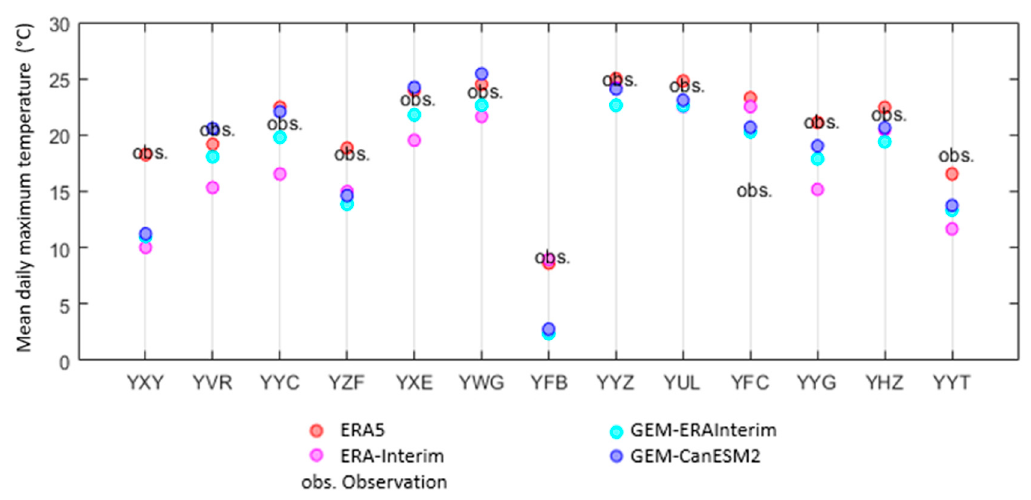
Figure 2. ( a ) Spatial plots of mean and standard deviation (SD) and ( b ) point (airfield) values of mean of daily maximum 2 m temperature for summer (JJA) from observations, ERA5 reanalysis, ERA-Interim reanalysis, GEM-ERAInterim, and GEM-CanESM2, for the 1981–2010 period.